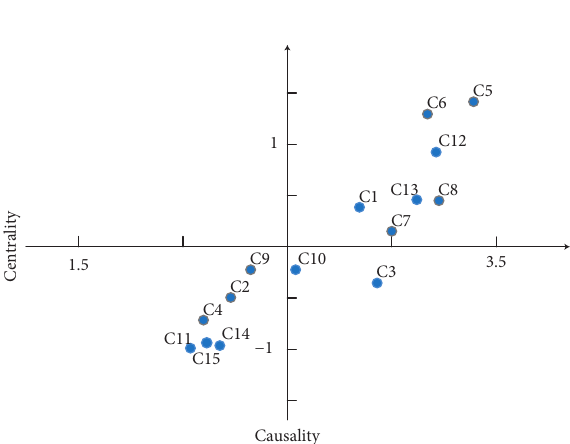
Figure 1: DEMATEL causal